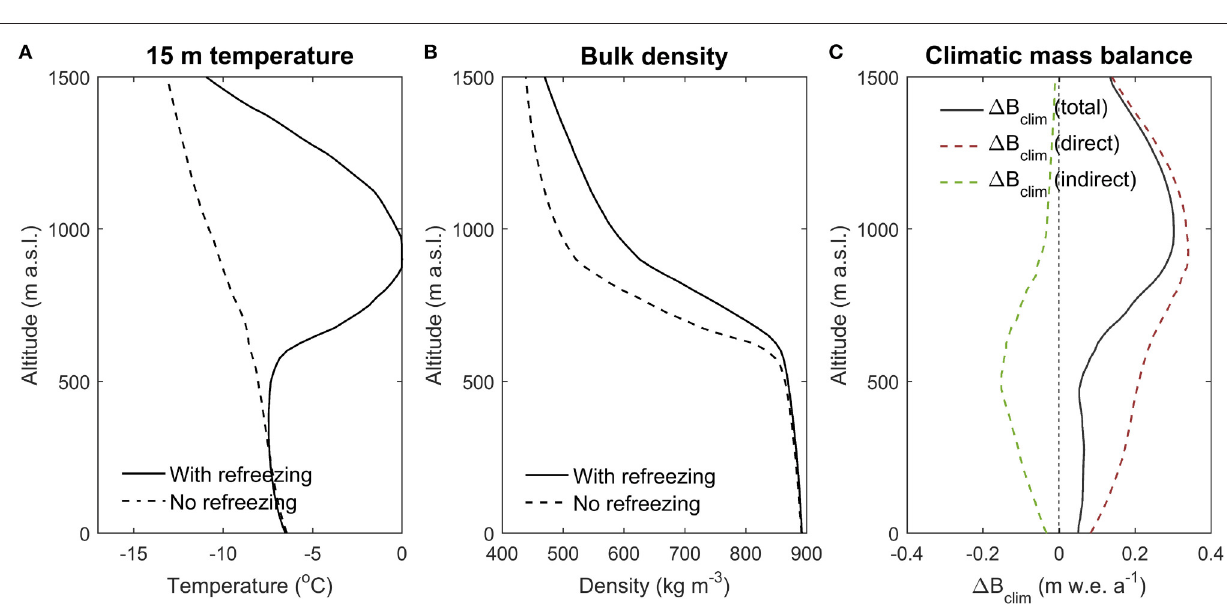
FIGURE 7 | Elevation profiles of subsurface (15-m) temperature (A) and bulk density in the upper 10m (B) , averaged for the period 1984–2104, for a run with and without refreezing. In (C) the net mass balance impact of refreezing is shown and is split into contributions from direct and indirect effects; 1 B clim (total) is calculated by subtracting climatic mass balance of the no-refreezing run from the refreezing run, 1 B clim (direct) is the direct effect of refreezing on the climatic mass balance and is equal to total refreezing in the vertical column, and 1 B clim (indirect) represents the indirect impact of refreezing on the climatic mass balance related to firn heating and